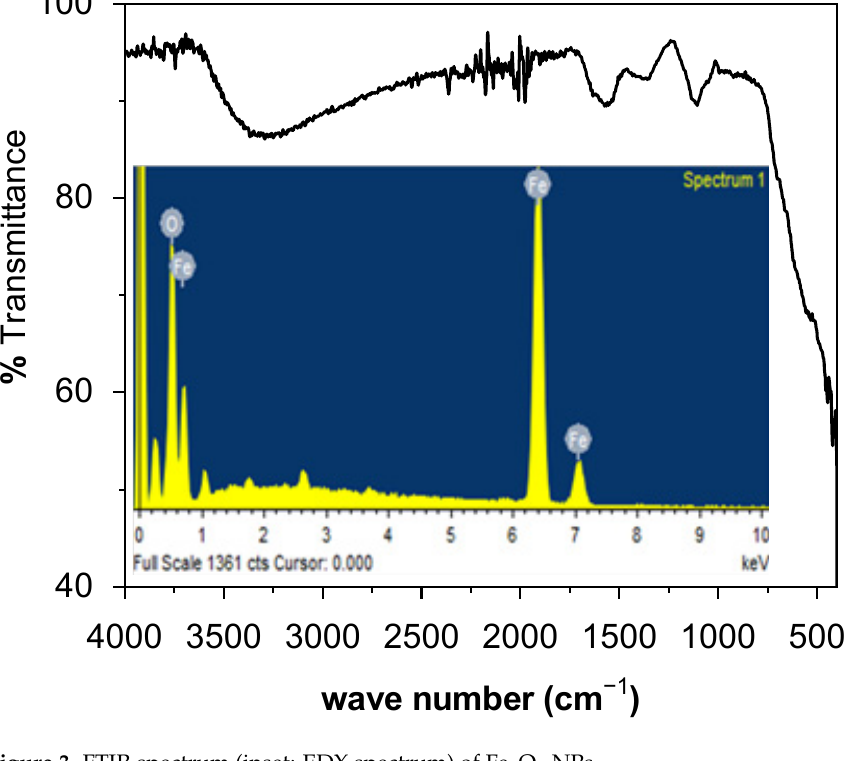
Figure 3. FTIR spectrum (inset: EDX spectrum) of Fe 2 O 3 NPs.